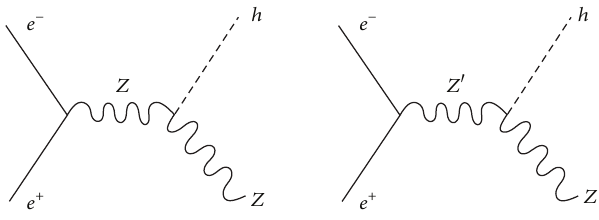
Figure 1: Feynman diagram for the Higgs-strahlung process 𝑒 + 𝑒 − → 𝑍ℎ in the 𝐵 − 𝐿 model. where 𝑁 𝑓 is the color factor ( 𝑁 𝑓 = 1 for leptons, 𝑁 𝑓 = 3 for quarks) and the couplings 𝑔 the SM fermions are given in